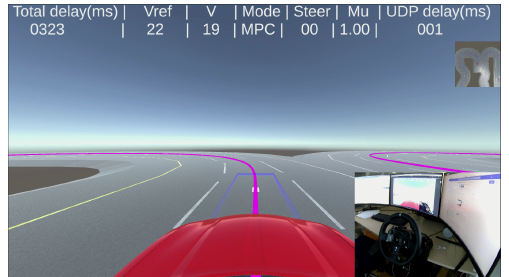
Figure 10. A snapshot of simulation in SRPT mode. Using steering joystick, human operator tries to keep the blue steer indicator on the purple trajectory. The NMPC controller inside the vehicle tries to follow the received